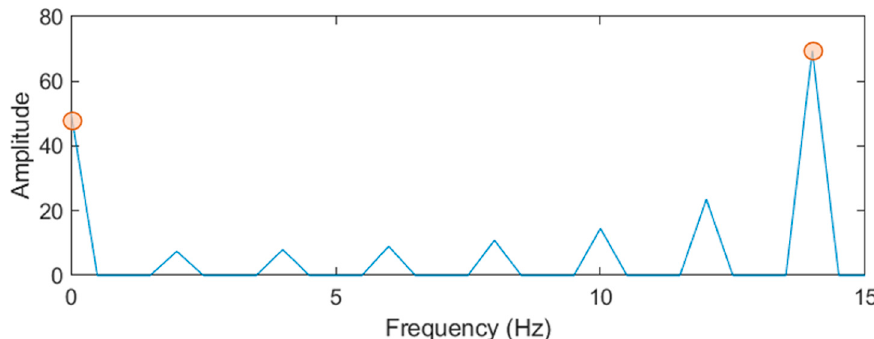
Figure 5. Example of the Fourier transform from simulation S3, with evidence (orange) of the frequency peak (14 Hz) and the fundamental frequency (0